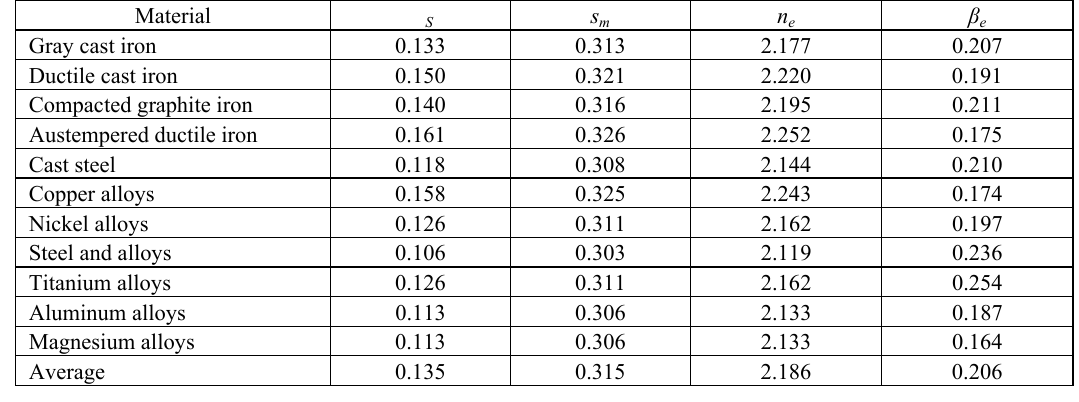
Table A4: Nominal Endurance Strength Factor for common Gear Materials at 99% Reliability Material (cid:31) S s m n e β e Gray cast iron 0.133 Ductile cast iron 0.150 Compacted graphite iron 0.140